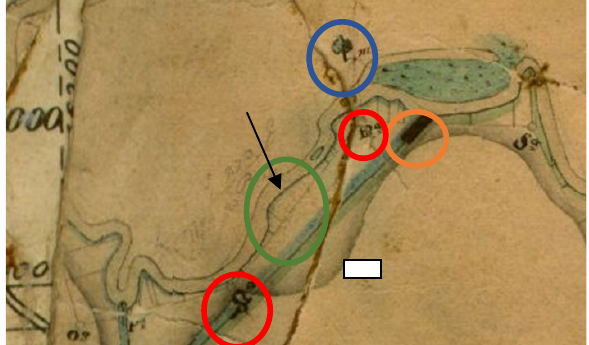
Figure 2: Section of the historical map fitting the field sheet provided in Figure 1.